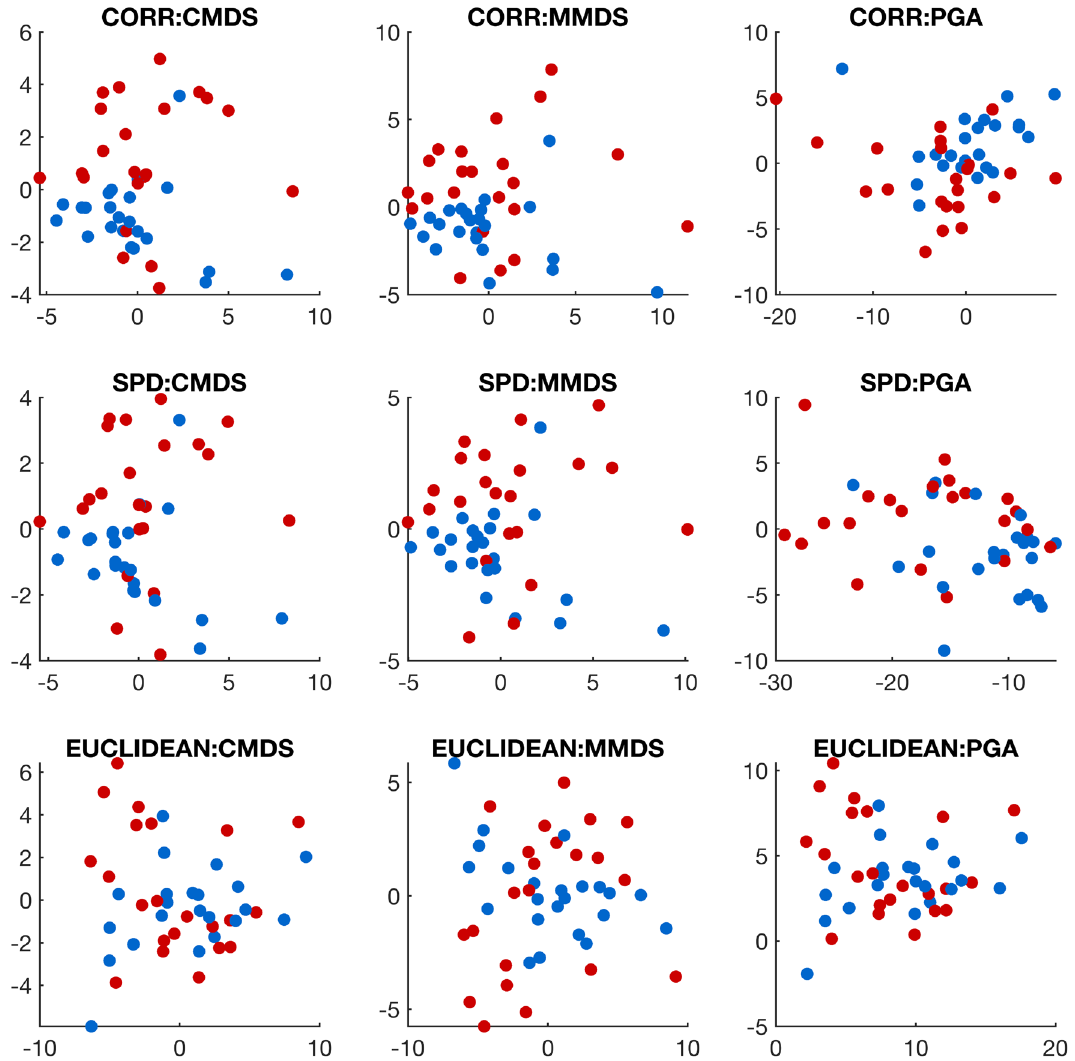
Figure 6. Embeddings onto 2-dimensional Euclidean space for a collection of motor imagery correlation matrices. Rows correspond to a choice of geometric structure by viewing the matrices as elements of the correlation manifold (top), the SPD manifold (middle), and the Euclidean space (bottom). Columns represent algorithms used under each geometry, including classical multidimensional scaling (left), metric multidimensional scaling (center), and principal geodesic analysis (right). Colors represent two classes of fists (in red) and feet (in